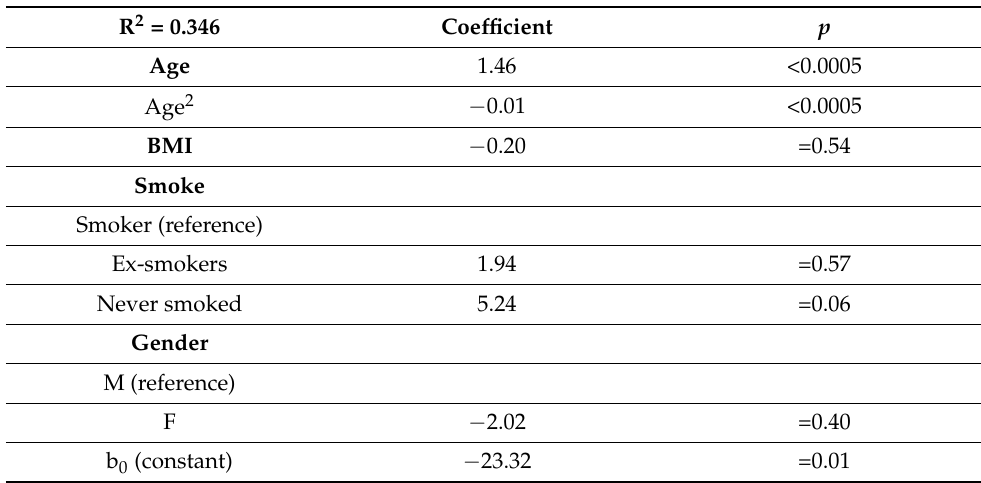
Table 2. Coefficients and significance estimates of